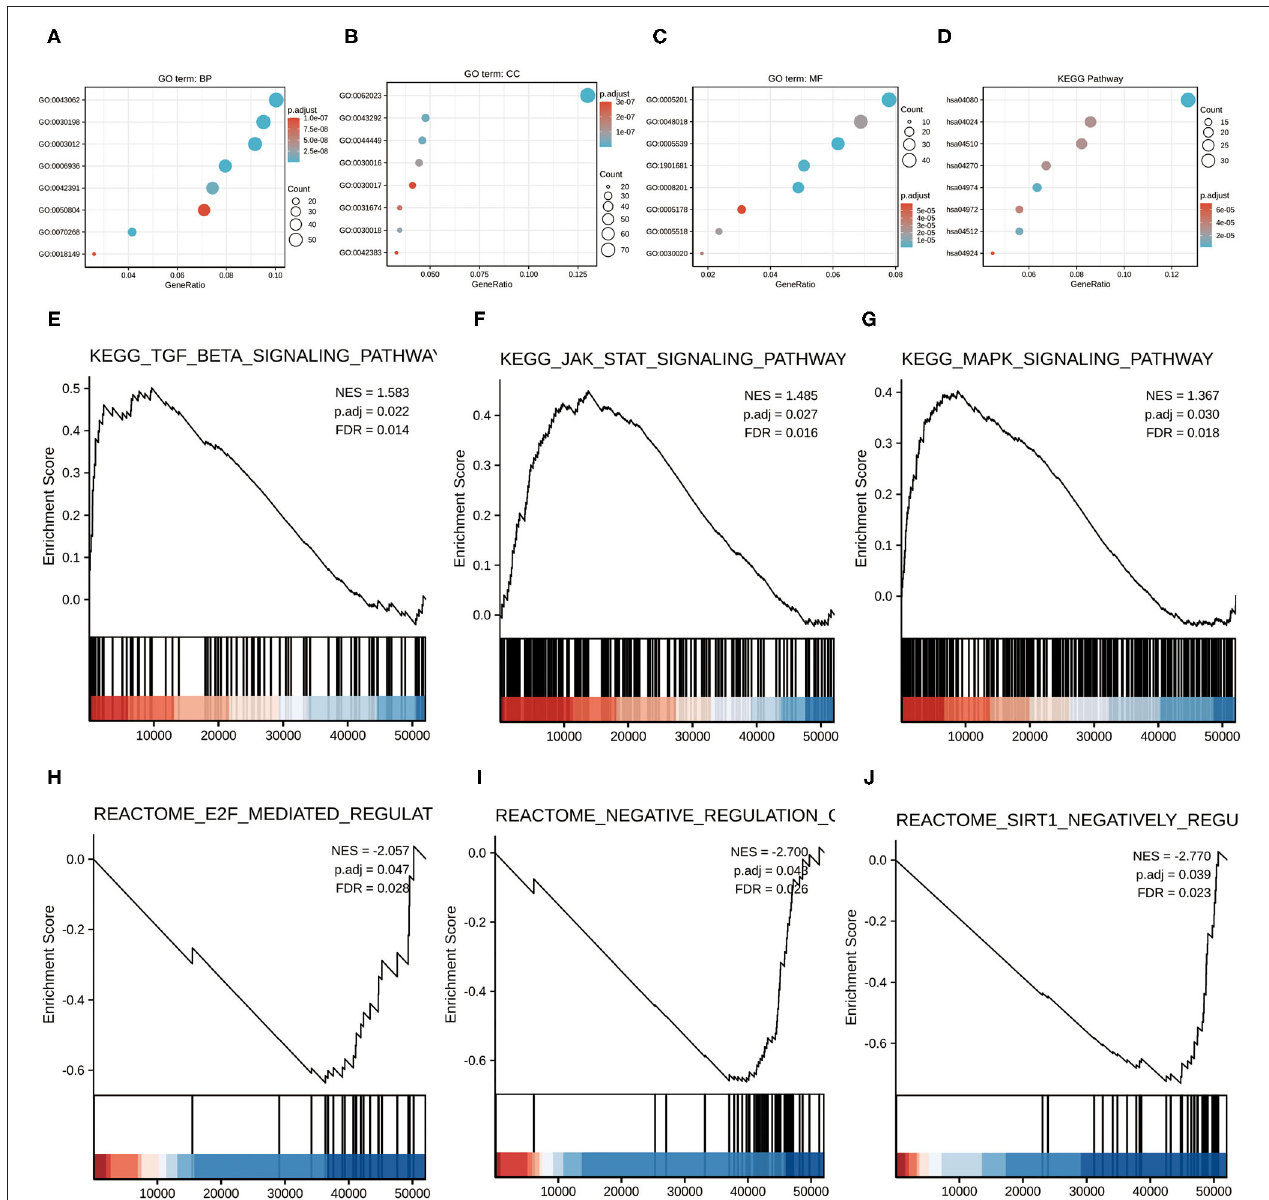
FIGURE 2 | Functional enrichment analysis of 256 differentially expressed genes (DEGs) between high and low expression of lncRNA MSC-AS1 in patients with gastric cancer in TCGA. (A) Enriched Gene Ontology (GO) terms in the biological process category. (B) Enriched GO terms in the cellular component category. (C) Enriched GO terms in the molecular function category. (D) Enriched GO terms in the Kyoto Encyclopedia of Genes and Genomes (KEGG) category. The X-axis represents the proportion of DEGs, and the Y-axis represents different categories. The different colors indicate different properties, and the different sizes represent the numbers of DEGs. (E–J) Enrichment plots from Gene Set Enrichment Analysis (GSEA). The TGF- β signaling pathway, the JAK-STAT signaling pathway, and the MAPK signaling pathway were differentially enriched in the long non-coding RNA (lncRNA) MSC-AS1 high-expression phenotype. In the lncRNA MSC-AS1 low-expression phenotype, enriched pathways included E2F mediated regulation of DNA replication, negative regulation of NOTCH4 signaling, and SIRT1 negatively regulates RNA